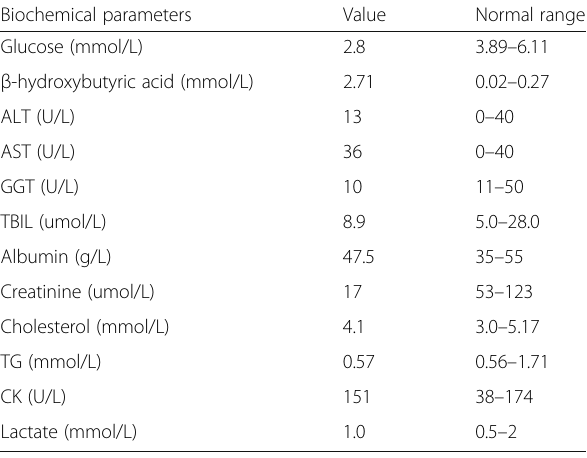
Table 1 Biochemical characteristics Biochemical parameters